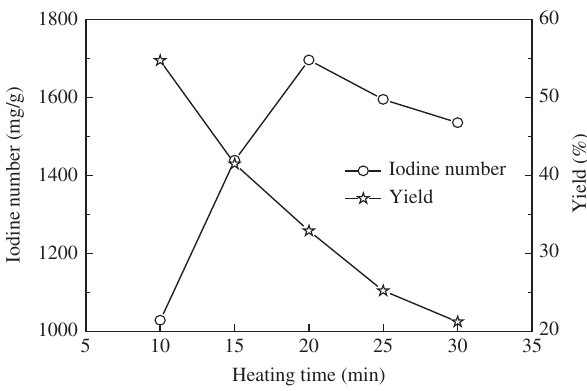
Figure 4: Effect of heating time on iodine number and yield of high surface area activated carbon (HSAAC).